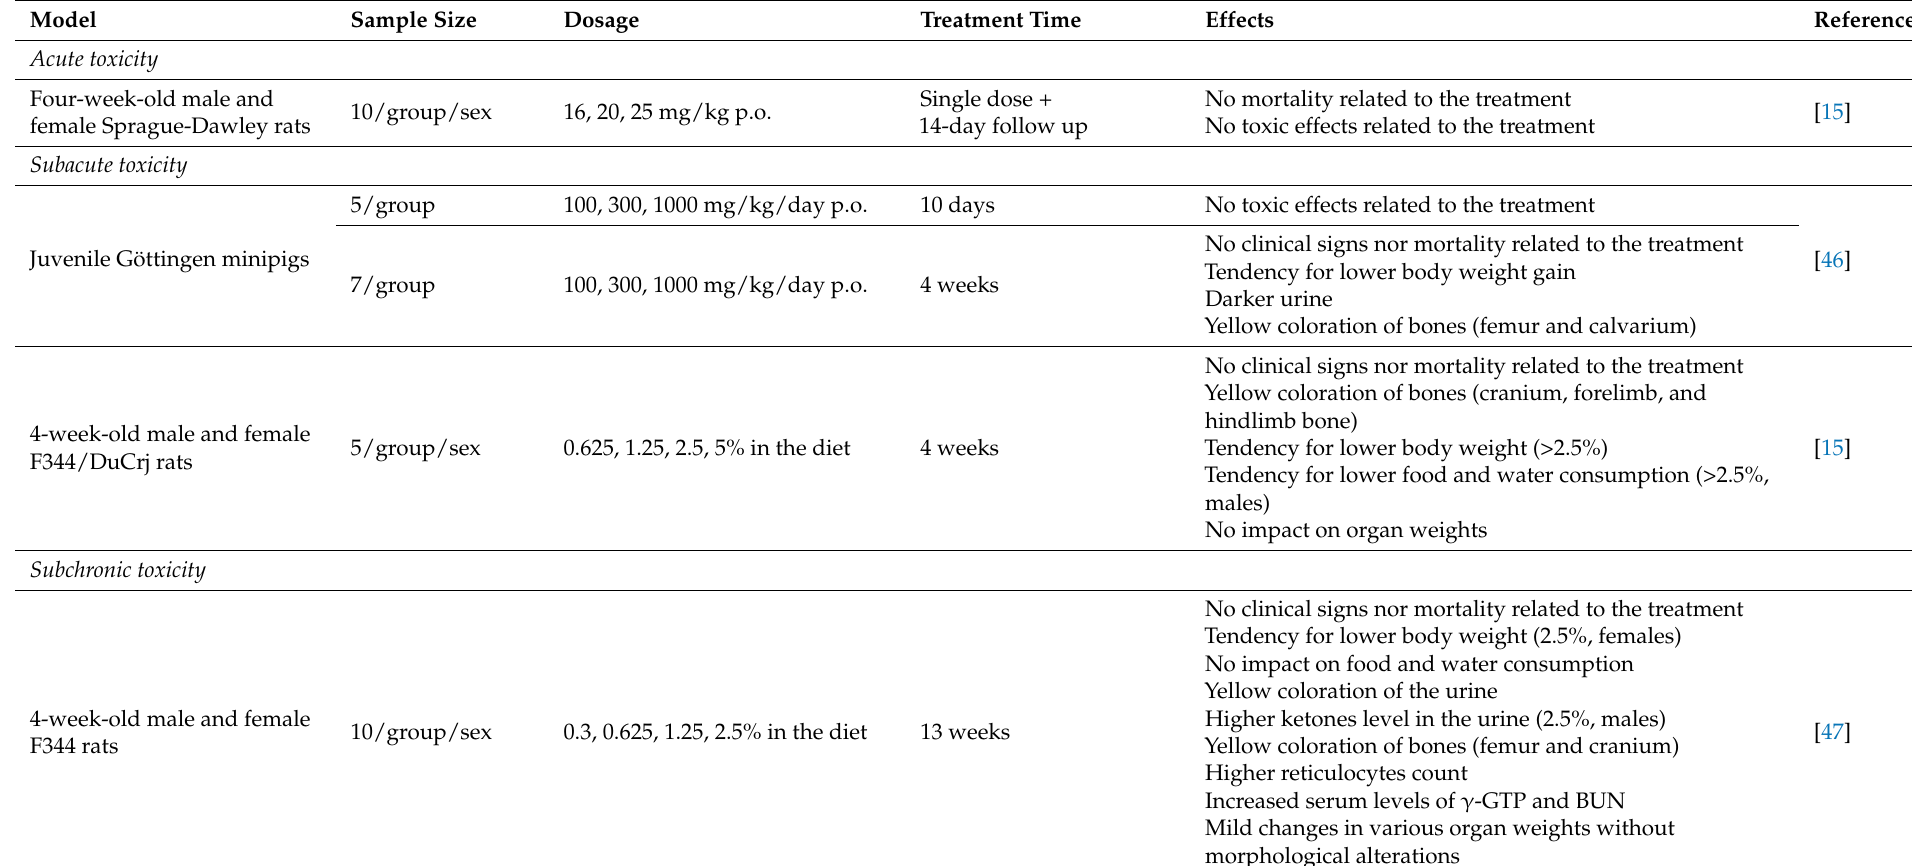
Table 2. Toxicity studies of